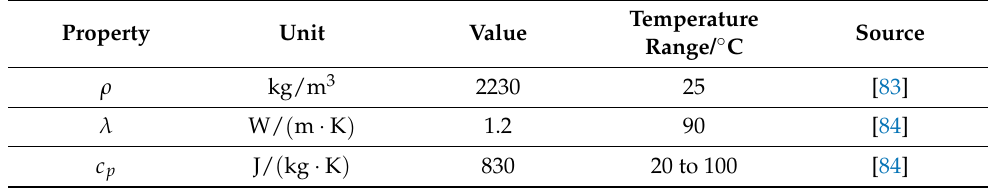
Table A3. Thermal properties of glass substrate.